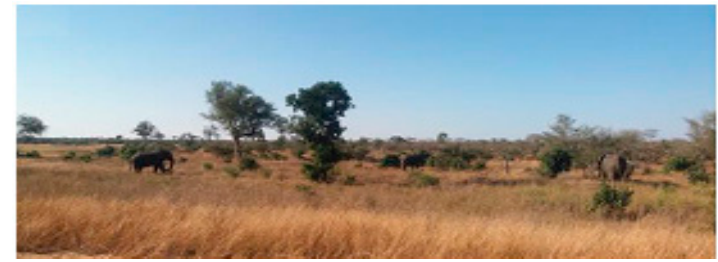
Figure 2. Typical landscapes found within the Kruger National Park.